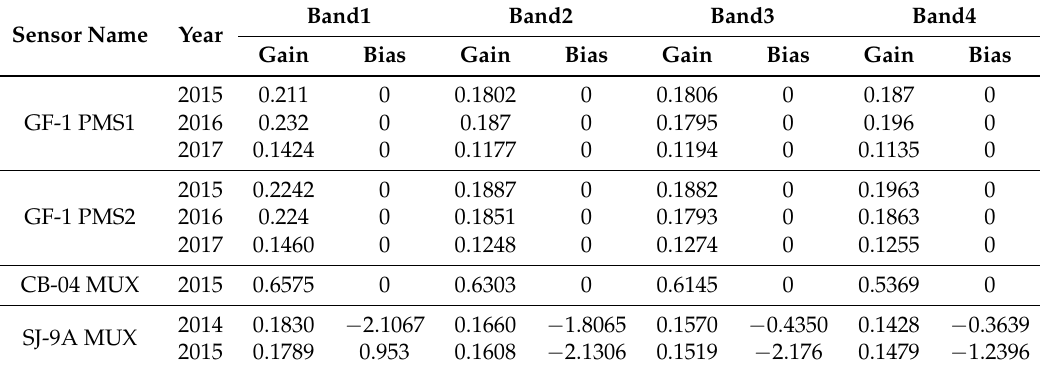
Table A2. Satellite parameter used in the experiment from CRESDA (China Centre for Resources Satellite Data and Application; W × m − 2 × sr − 1 × µ m − 1